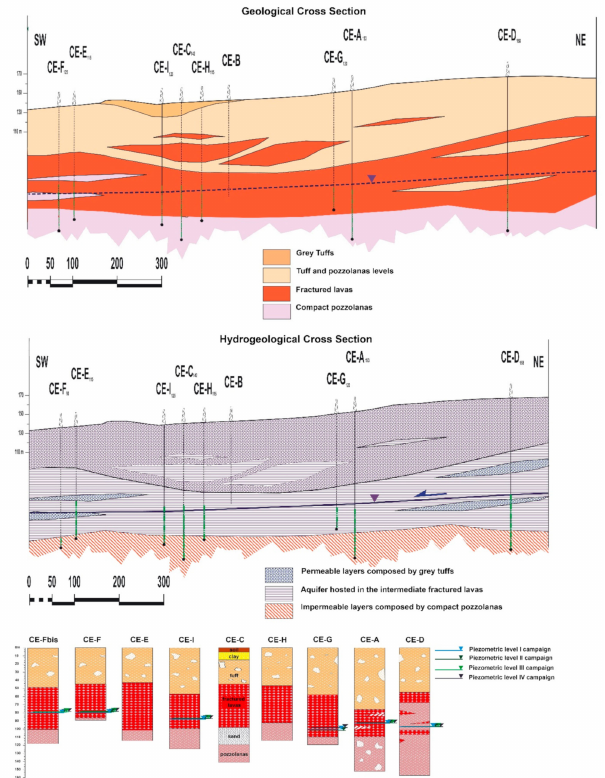
Figure 2. Geological and hydrogeological cross sections within the municipal solid waste disposal dump and stratigraphic correlation of the piezometers